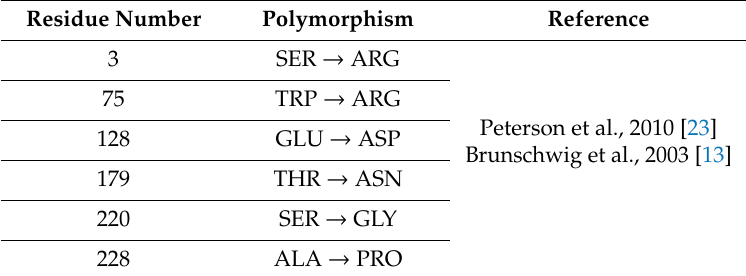
Table 2. Amino acid polymorphisms reported for PMEPA1 .